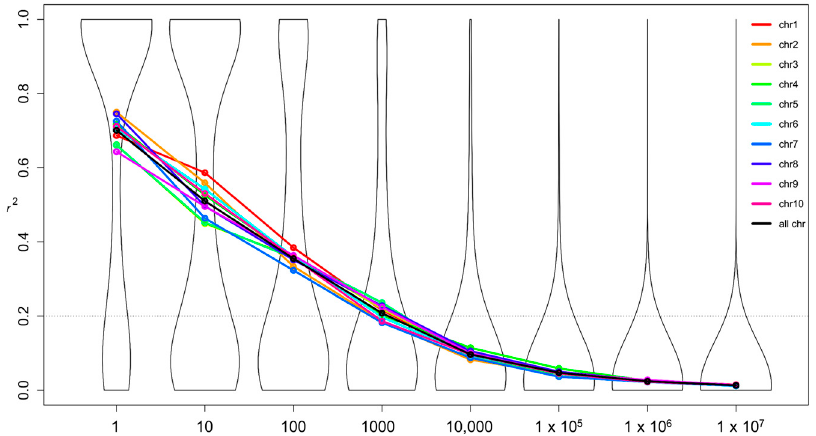
Figure 4. Linkage disequilibrium decay across the 10 maize chromosomes based on 29,188 SNPs. The black line represents the average of all chromosomes, and the violin plot showing the distribution of all r2 values is depicted in the background. Dotted lines represent the threshold of 0.2.